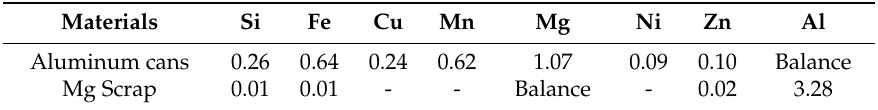
Table 1. Chemical composition of the materials used during the aluminothermic reduction of Mn 2 O 3 powders (wt